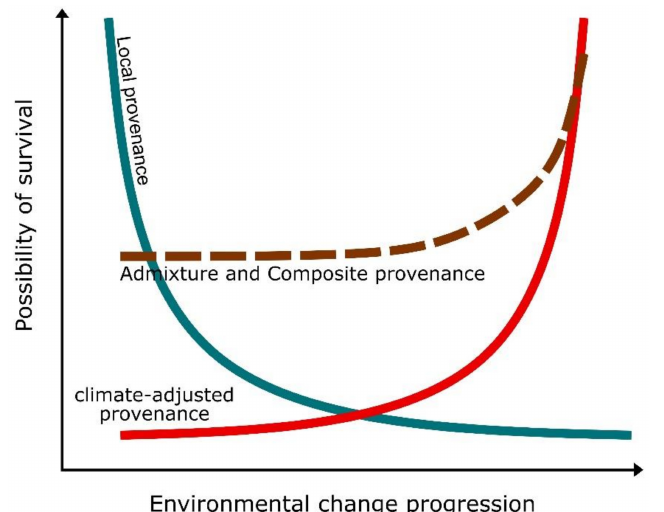
Figure 2. Graph showing the conceptual relationship between local (blue line), climate-adjusted (red line), admixture and composite (dashed line) provenance ( sensu Prober et al. [99]) with the possibility of survival of the restored seagrasses under environmental change (e.g., ocean warming, eutrophication,